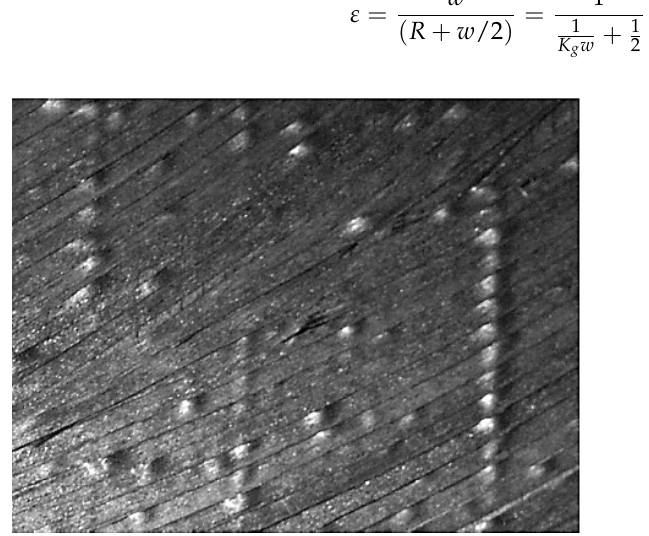
Figure 3. Schematic diagram of fiber buckling and wrinkling.